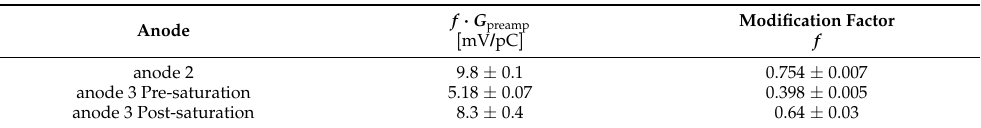
Table 5. Using the measured pre-amplifier without the circuit response ( G CR − 112 preamp = 11.7 ± 0.6 mVpC − 1 ) and the measurements of the pre-amplifiers connected to the detector f · G preamp , the circuit response modification-factor f is determined